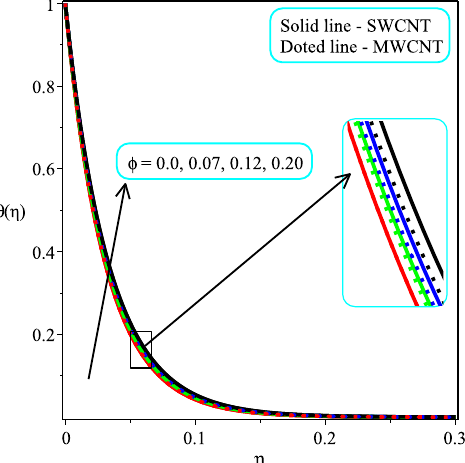
Figure 4. Repercussion of κ with Φ = 0.1, M egt = 2, Ω = 2, ω = π /4 on velocity profiles.